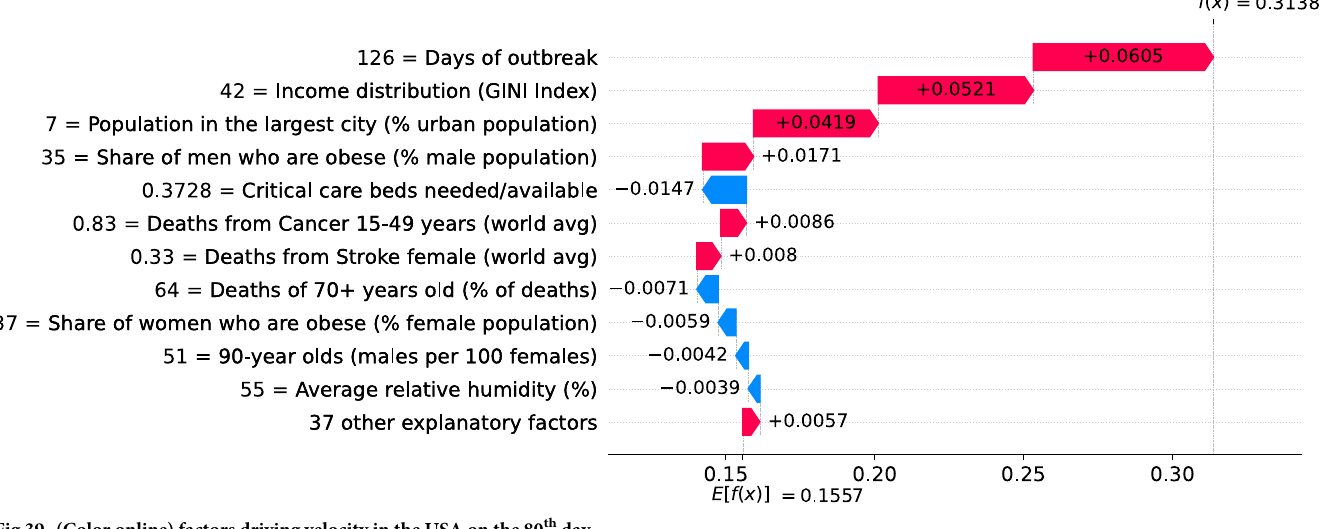
Fig 39. (Color online) factors driving velocity in the USA on the 80 th day.